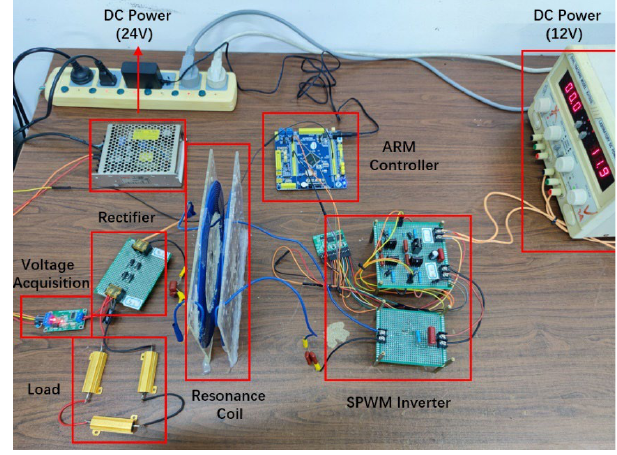
Figure 11. The WPT experimental circuit based on S-S compensation.